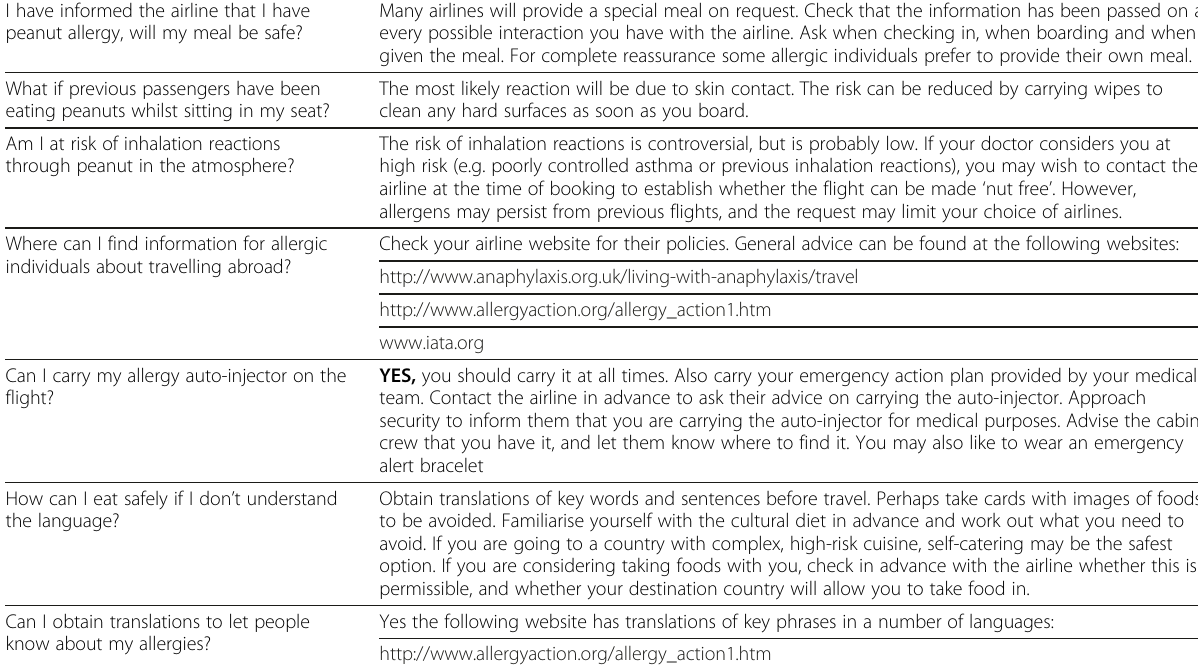
Table 2 How can the Health professional respond to frequently asked